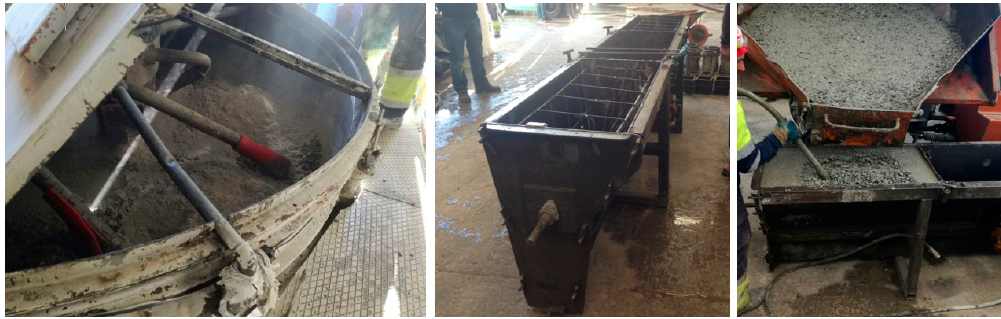
Figure 2. Precast element manufacturing sequence.